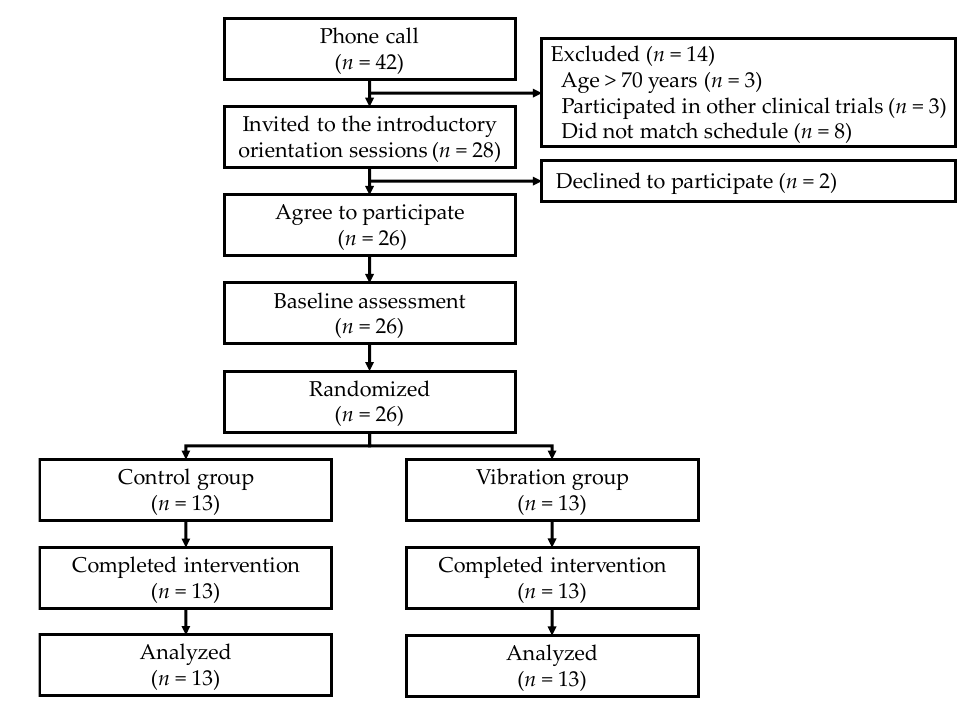
Table 1. Participant sociodemographic characteristics at baseline.